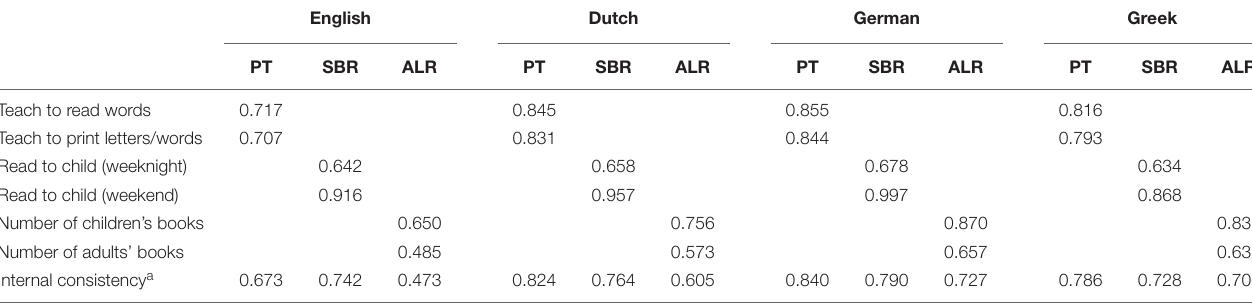
TABLE 2 | The standardized factor loadings for the measurement model of the HLE questionnaire in each orthography.